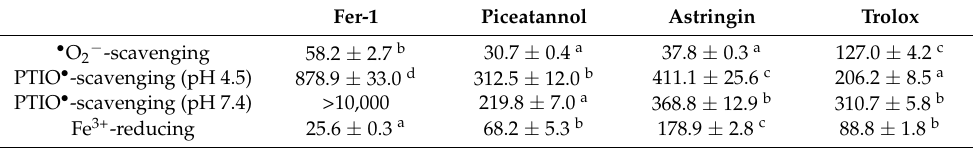
Table 1. IC 50 values ( µ M) of Fer-1, piceatannol, and astringin in antioxidant colorimetric